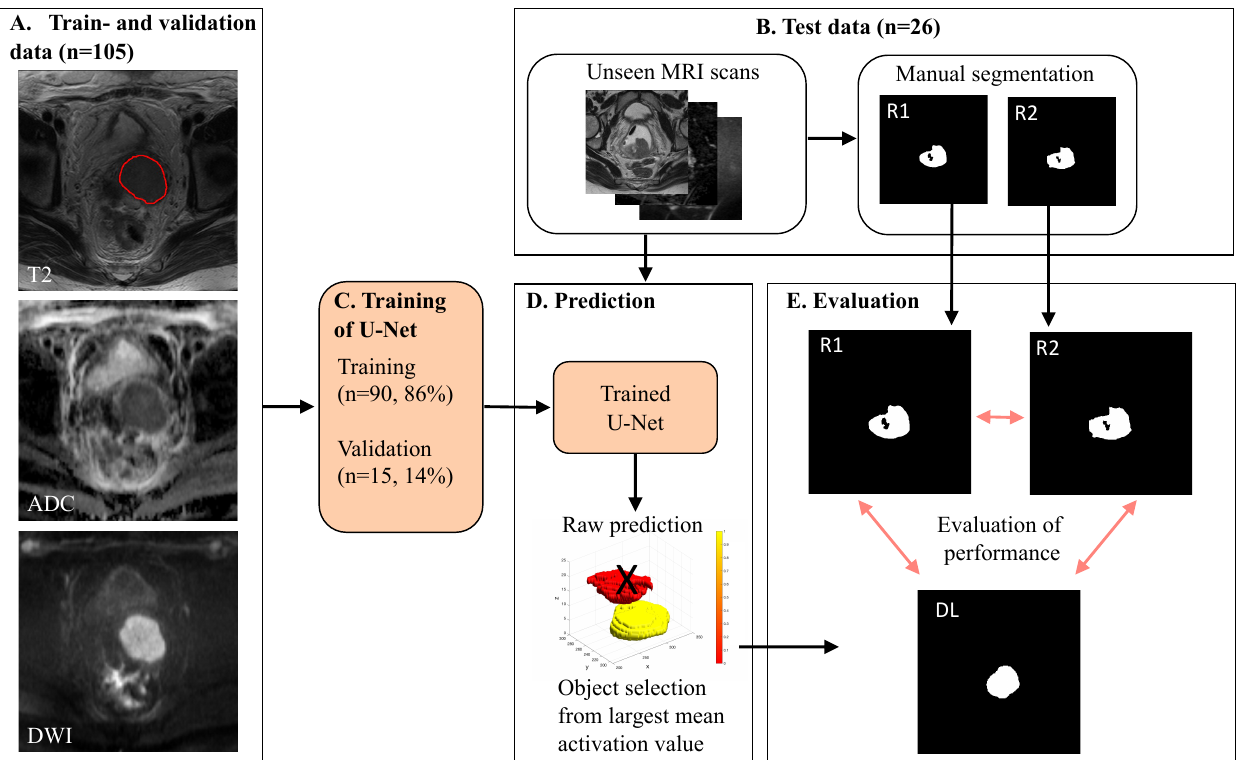
Figure 1. Graphical illustration of DL (deep learning) workflow and study setup. MRI data included T2-weighted images and diffusion weighted images (DWI), using high b-value images and apparent diffusion coefficient (ADC) maps at primary diagnostic work-up in 131 CC patients. ( A ) In the train and validation cohort ( n = 105), primary tumor was segmented by one of the two expert raters (R1: n = 58, R2: n = 47). ( B ) The test cohort ( n = 26), with primary tumor segmentations by both expert raters (R1 and R2), served as an unbiased test set for evaluating performance of the DL algorithm and inter-rater agreement. ( C ) The train and validation cohort ( n = 105) was used to train a 3D U-Net using 90/105 (86%) cases for training and 15/105 (14%) cases for validation. ( D ) The trained network predicted raw tumor masks in the test data set ( n = 26), identifying multiple regions in 23/26 cases. The object with the largest mean activation value was selected as primary tumor (yellow object). Other objects with lower mean activation values (red object) were removed from further analysis (indicated by a black cross). ( E ) DL-derived tumor masks were compared with manually segmented masks from R1 and R2, using Dice score and Hausdorff distances. R1 = Rater 1, R2 = Rater